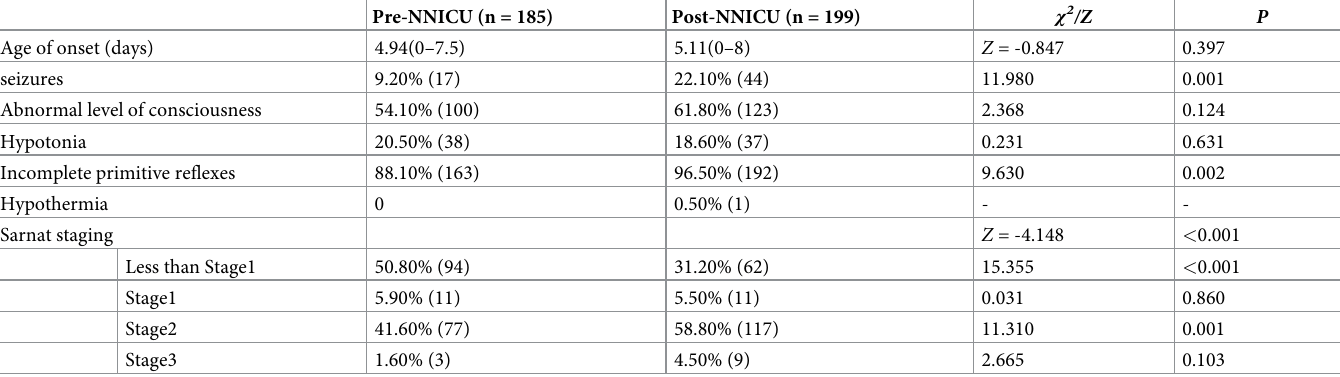
Table 2. Clinical features of the